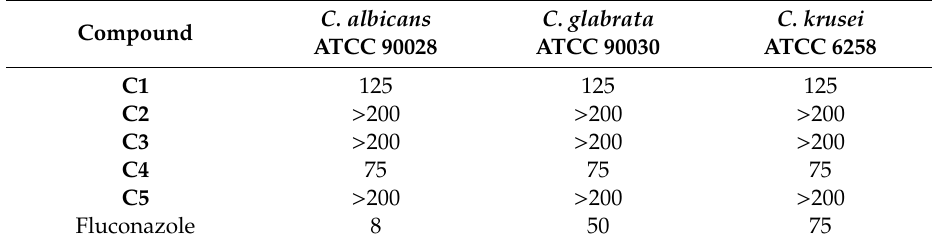
Table 3. The minimum inhibitory concentration values (MIC, μ g/mL) of the compounds C1-C4 , n = 3.